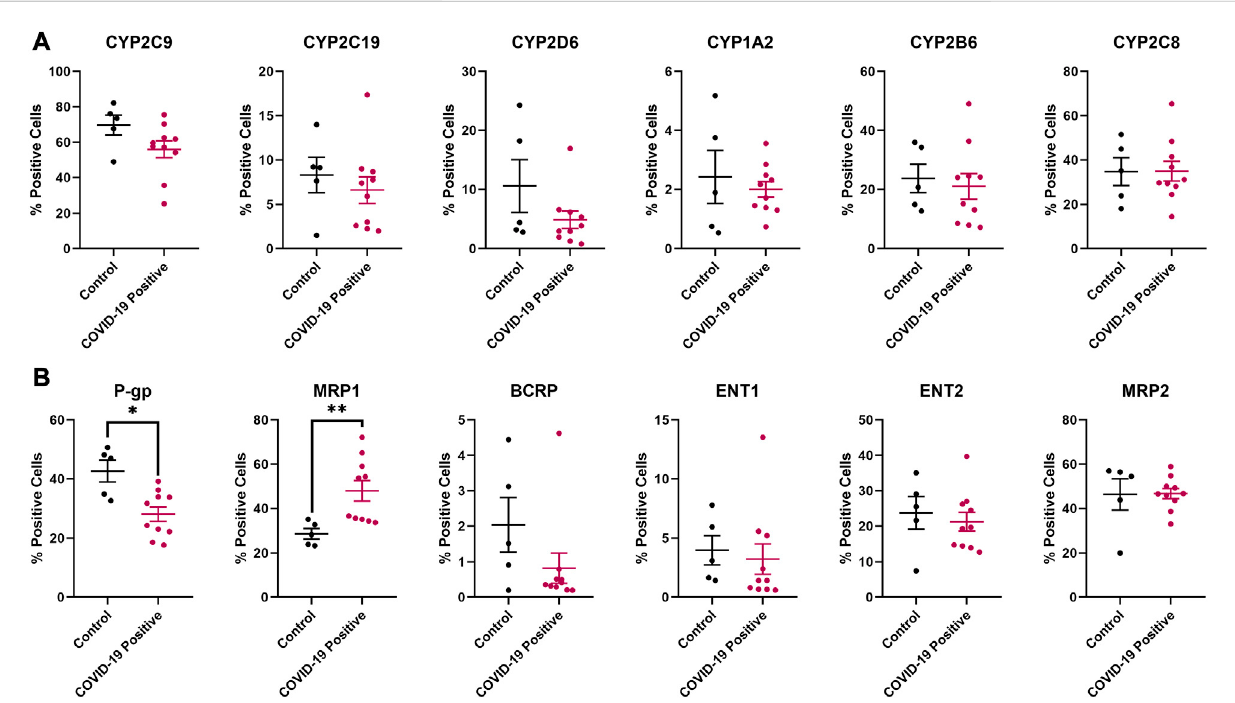
FIGURE 6 Effect of COVID-19 on the protein expression of selected (A) drug metabolizing enzymes and (B) membrane-associated drug transporters in postmortem human lung tissues. Chromogenic images obtained from the immunostained tissue slides from each subject were analyzed using HALO software v3.4 (Indica Labs) for absolute quantitative IHC analysis. Results are expressed as mean ± SEM, and the non-parametric two-tailed Mann- Whitney test was used to determine the differences in protein expression between COVID-19 and control postmortem human lung tissues for absolute quantitative IHC analysis (*, p < 0.05; **, p <